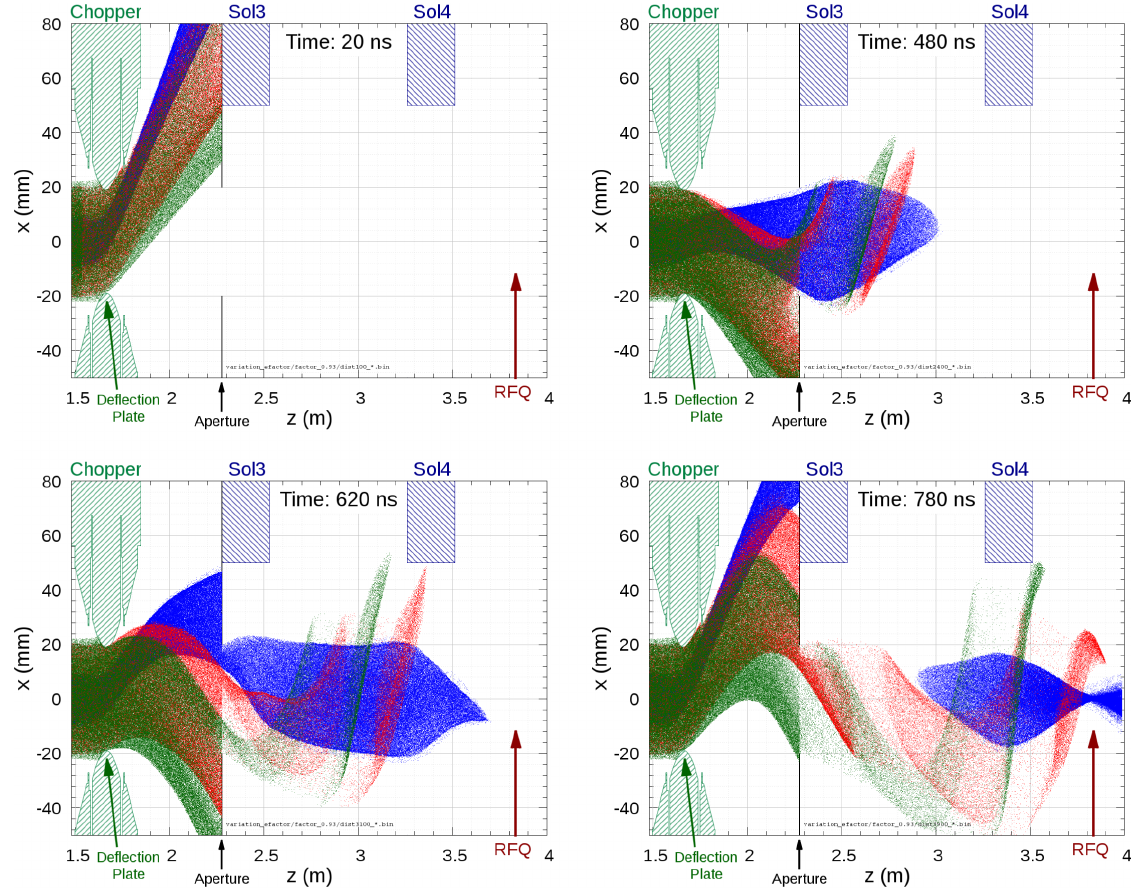
FIG. 5. Different time steps of a beam shaping simulation in the E × B chopper [3]. The dc beam enters the chopper from the left side. It is composed of 50 mA protons (depicted in blue), 5 mA H þ 2 ions (red) and 5 mA H þ 3 ions (dark green). The beam energy is 120 keV. The measured HV pulse is imported into the simulation and used to ramp the electric field. The proton pulse is shaped at a circular aperture with a 20 mm radius. The solenoids used for transverse focusing are shown in blue. The electric deflection plates and the repeller electrodes are depicted in